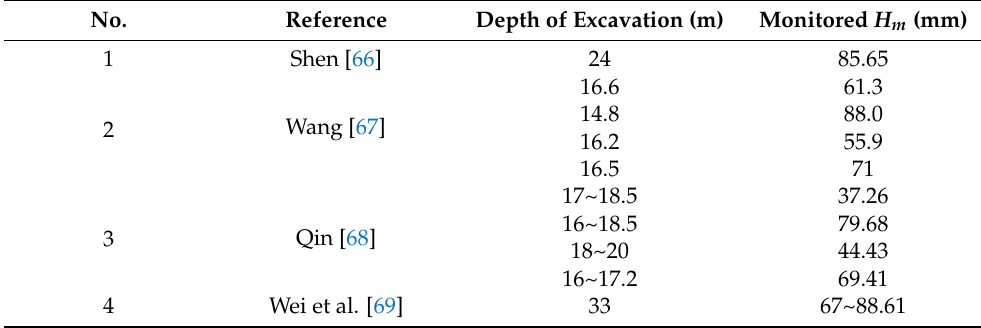
Figure 15. Effect of H con on settlement control guarantee rate ( R g ) and reliability index ( β ). Table 6. Surface settlement values for similar excavation projects in the Hangzhou area.